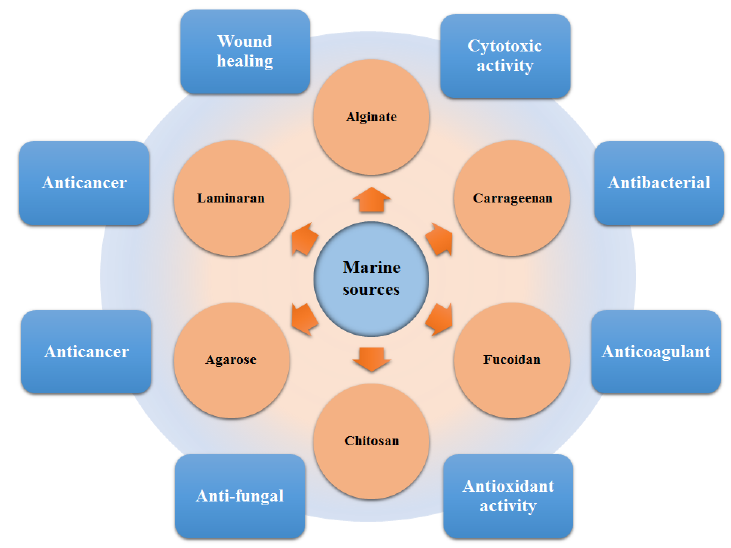
Figure 6. Bio- and non-bio-related applications of marine-based potential sources. Reproduced from Centella et al. [9], with permission from Elsevier.